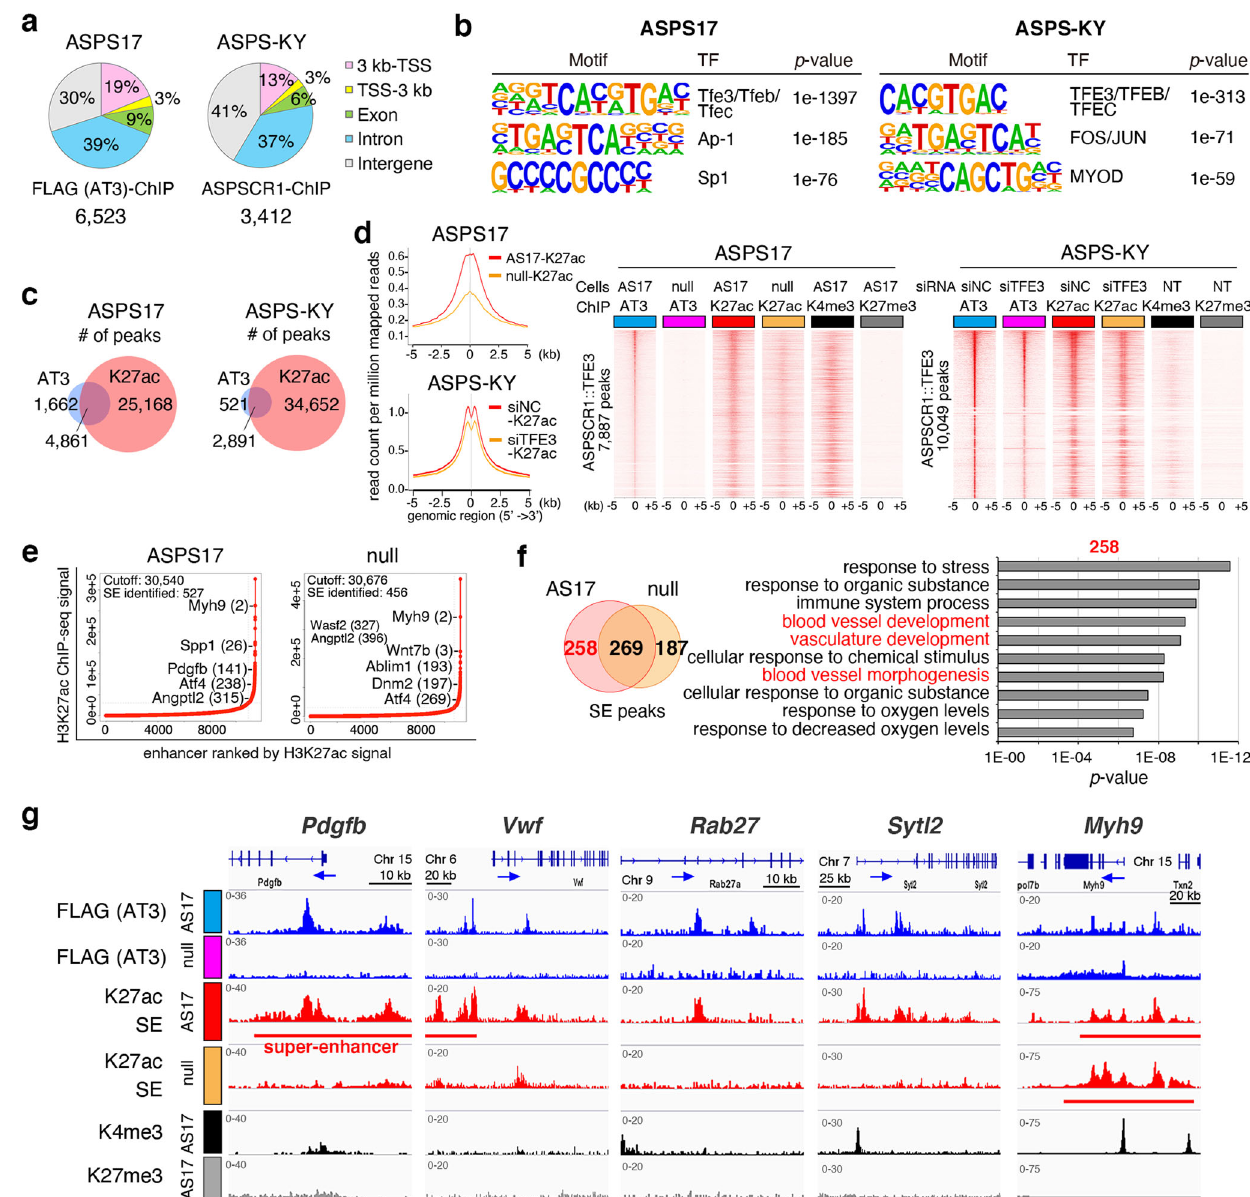
Fig. 2 | The loss of ASPSCR1::TFE3 expression modulates distribution of super- enhancers (SEs). a The genomic distribution of ASPSCR1::TFE3 6523 and 3412 boundsitesinmouseandhumanASPS,respectively,showingpredominantbinding in distal regions. Common bound sites in two biological replicates were analyzed. b De novo motif enrichment analysis of ASPSCR1::TFE3 binding regions in mouse (left) and human (right) ASPS. The top three motifs identi fi ed are shown. Motif enrichment and p -value was calculated using Fischer ’ s exact test. c Venn diagrams showing the number of common binding regions between ASPSCR1::TFE3 and H3K27ac in mouse and human ASPS. d Composite plots showing a signi fi cant reduction in H3K27ac signals in the absence of ASPSCR1::TFE3 in both mouse and human ASPS (left). Heat maps showing ASPSCR1::TFE3, H3K27ac, H3K4me3, and H3K27me3 signals in murine ASPS17 and human ASPS-KY cells. Reduction in